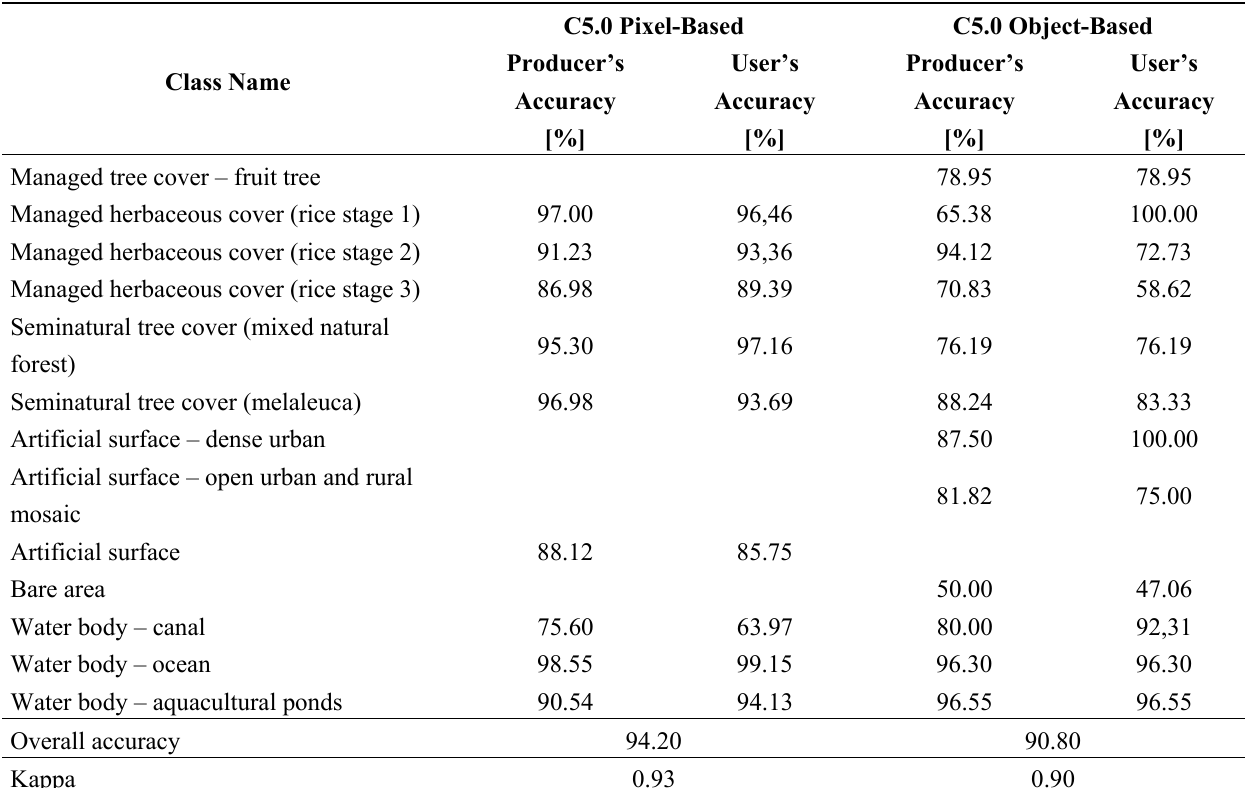
Table 2. Producer’s, user’s and overall accuracies and kappa coefficients for C5.0 pixel-based and object-based classification results of Spot5 image